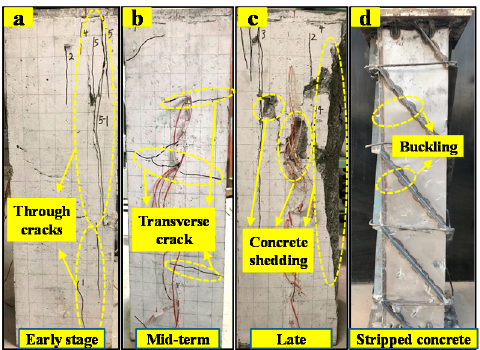
Figure 6. Z2 destruction phenomenon. ( a ) Early stage ( b ) medium stage ( c ) Late stage ( d ) Stripped